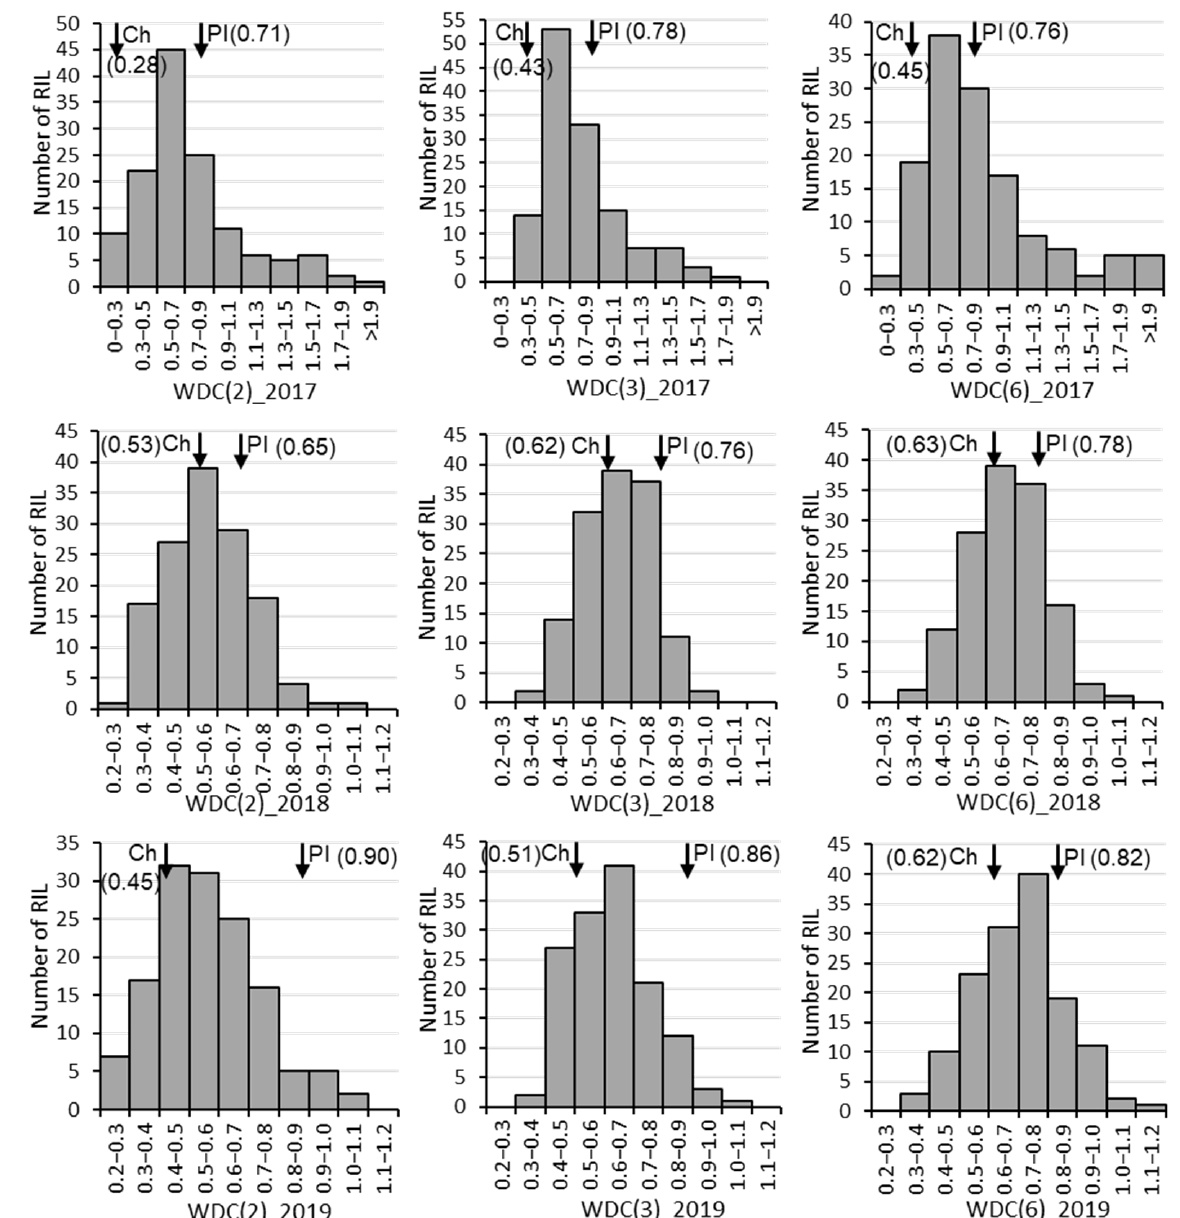
Figure 1. Frequencies in recombinant inbred line number for weighted drought coefficient (WDC) from 2017 to 2019. Ch and PI next to the inverted arrow ( ↓ ) with WDC value inside parentheses are abbreviated for the parents ‘Cheonsang’ and ‘PI416937’, respectively. The values in the parentheses after WDC indicate the number of traits considered to calculate WDC: 2 (biomass and leaf area), 3 (plant height, biomass, and leaf area), and 6 (plant height, node number, branch number, pod number, biomass, and leaf area). Table 1. Weighted drought coefficient (WDC) of the parents and recombinant inbred lines (RILs) for three years (2017–2019) and their mean.